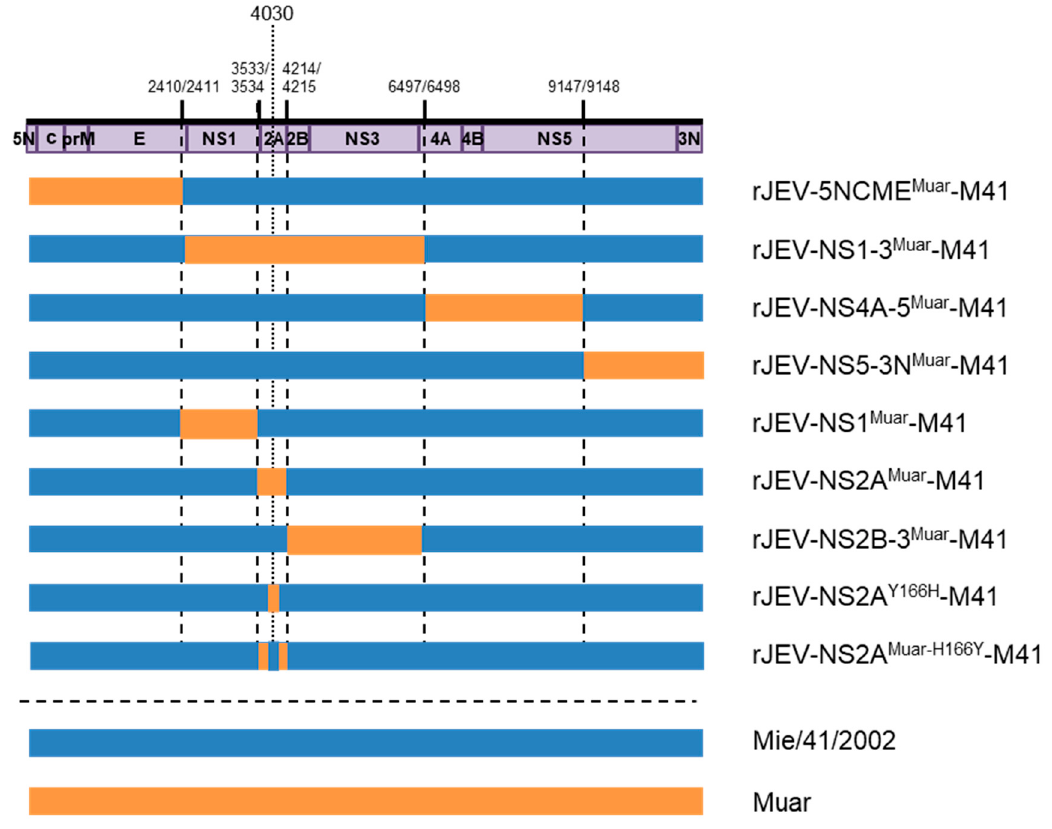
Figure 1. Schematic representation of the genomic structure of mutant Japanese encephalitis viruses (JEVs) used in this study. Regions derived from Mie/41/2002 and Muar strains are shown in blue and orange, respectively; numbers: nucleotide positions in the Mie/41/2002 genome.